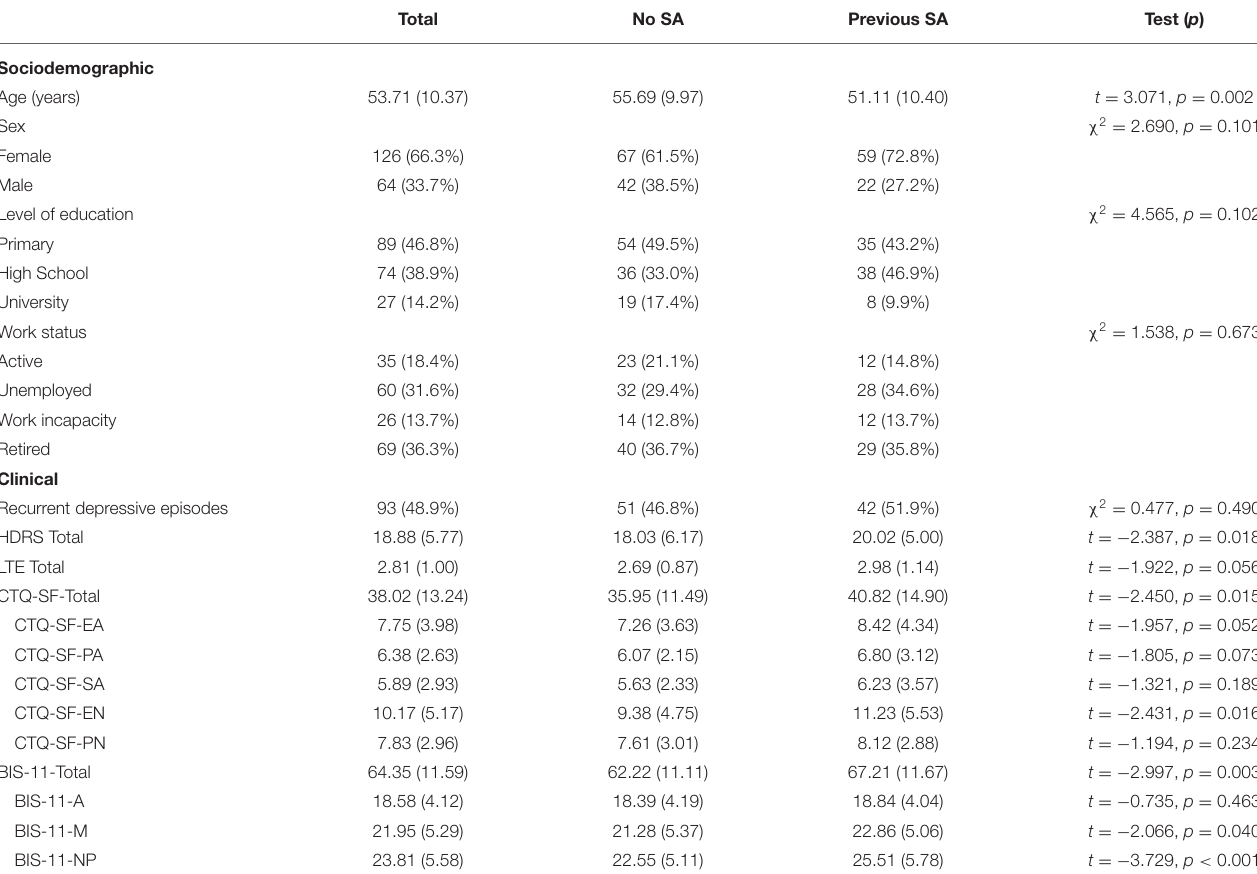
TABLE 1 | Sociodemographic and clinical characteristics of the sample ( n = 190): [mean ( SD )] or ( n , %). Total No SA Previous SA Test ( p )